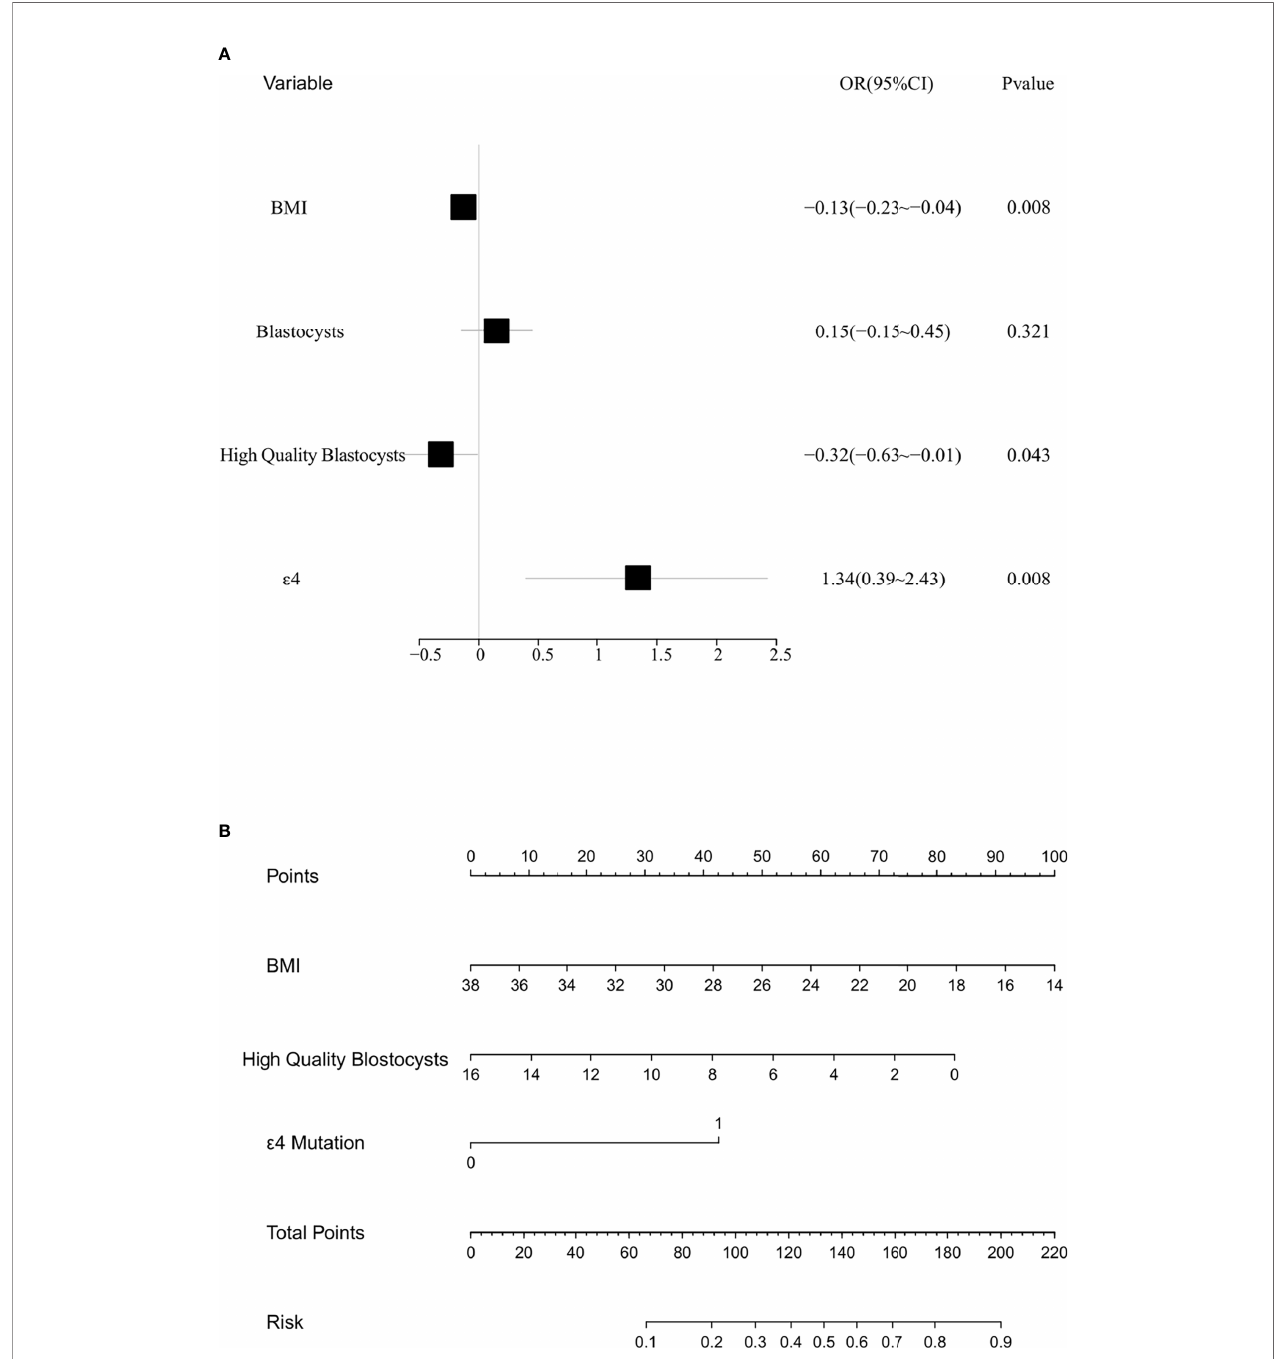
FIGURE 2 | Multivariate analysis and risk assessment of the control subjects and patients with EMT. (A) Forest map from the multivariate analysis of the control subjects and patients with EMT; BMI, p = 0.008; high-quality blastocysts, p = 0.043; ApoE- ϵ 4, p = 0.008. (B) Nomograph for predicting patients with